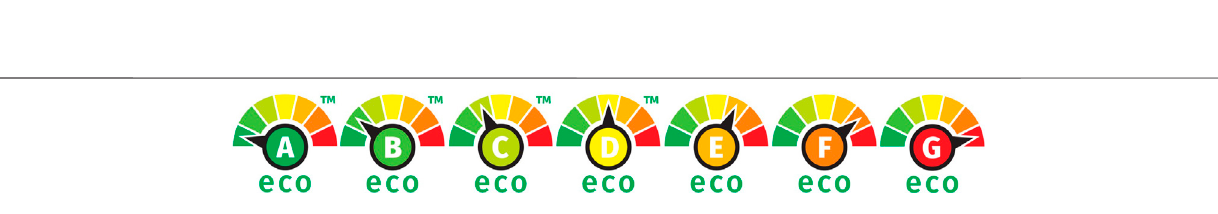
FIGURE 4 | Label “ Environmental compatibility of a sunscreen, ” the visuals as used in the DSM SUNSCREEN OPTIMIZER ™